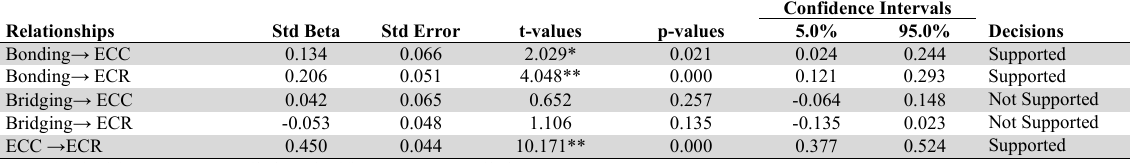
Confidence Intervals